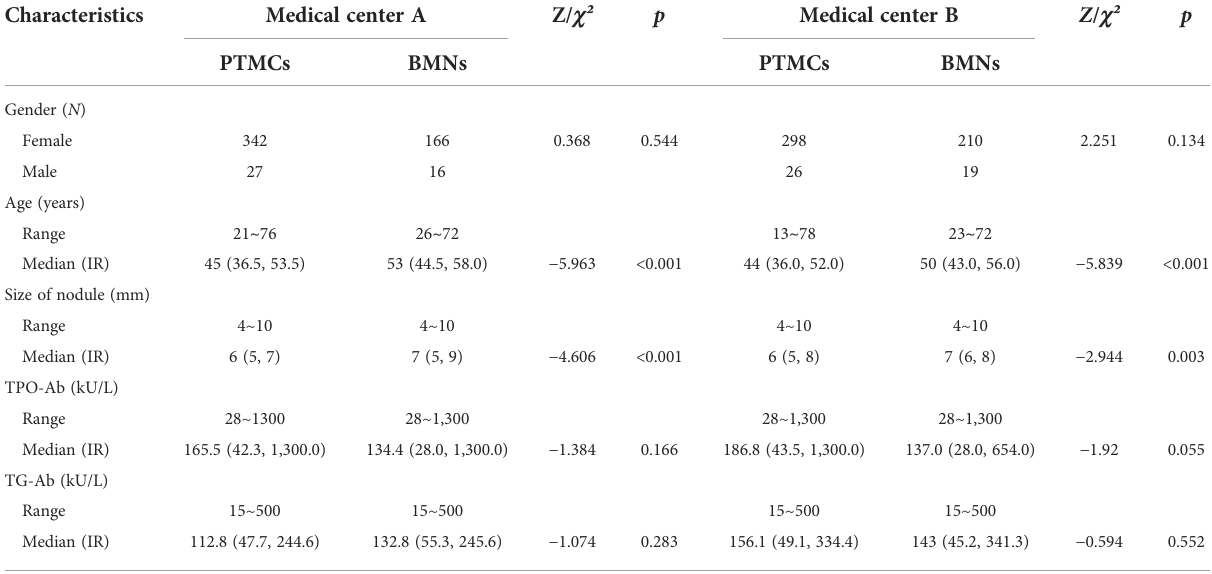
TABLE 1 Distribution of gender, age, size of nodules, TPO-Ab, and TG-Ab levels in PTMCs and BMNs in patients with HT in both medical centers. Characteristics